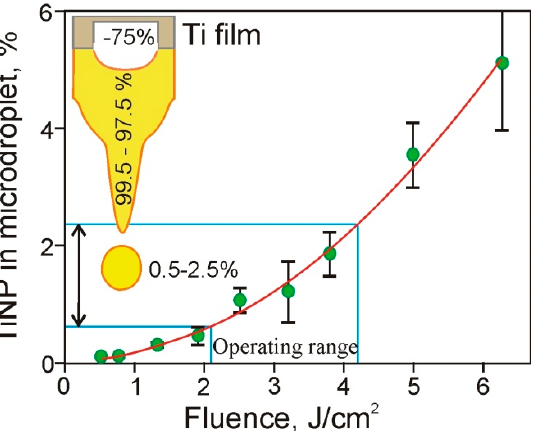
Figure 8. Dependence of the ratio (in percentages) of TiNP mass transferred in microdroplets to the mass of the ablated Ti film on the laser pulse fluence. The inset shows a titanium film, a jet of gel, and a microdroplet. The numbers on the Figure provide the percentage of material removed from the Ti film (~75%), as well as the percentage of the removed material located in the jet (99.5–97.5%) and in gel microdroplet (0.5–2.5%).